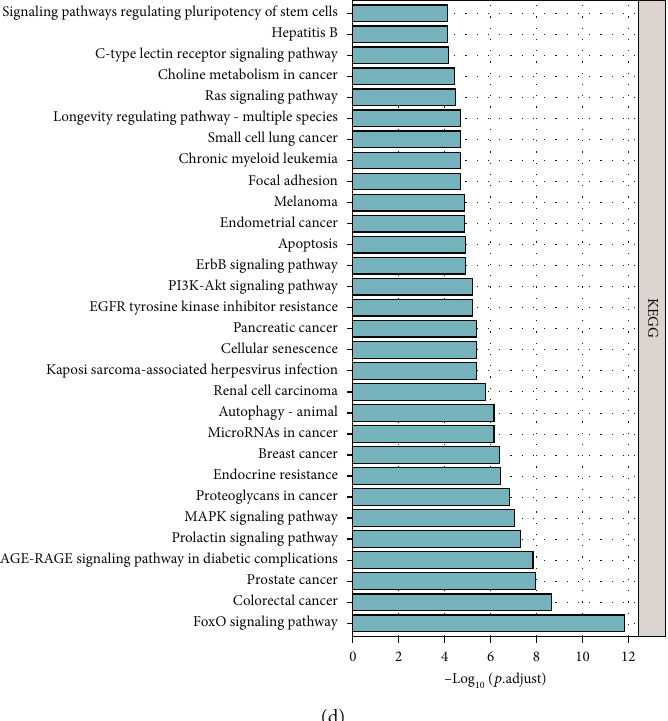
Figure 6: Exploration and functional enrichment analysis of the miRNAs target genes. (a) Venn diagram of target genes for six miRNAs from NRM signature based on miRDB, miRTarBase, and TargetScan. (b) Dot plot showing the results of gene ontology (GO) enrichment analysis of 392 potential target genes di ff erentially expressed between tumor samples and normal samples. (c) Circle network plot showing the relationships between the top fi ve enriched pathways of Kyoto Encyclopedia of Genes and Genomes (KEGG) enrichment analysis and their associated target genes. (d) Bar plot showing the results of KEGG enrichment analysis. Construction of miRNA – mRNA interaction network and identi fi cation of hub